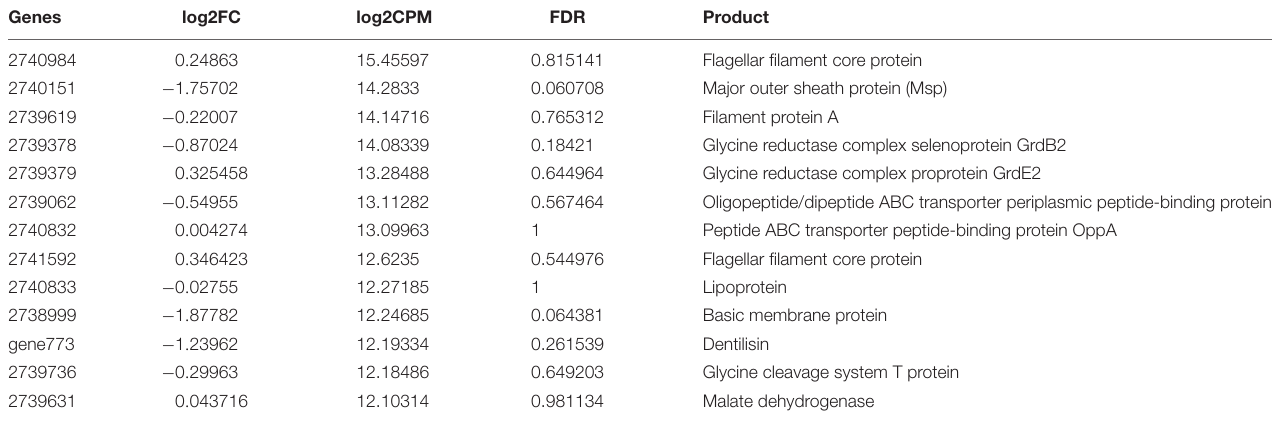
TABLE 4 | Highly expressed genes (log2CPM ≥ 12) in both periodontitis and laboratory culture in T.